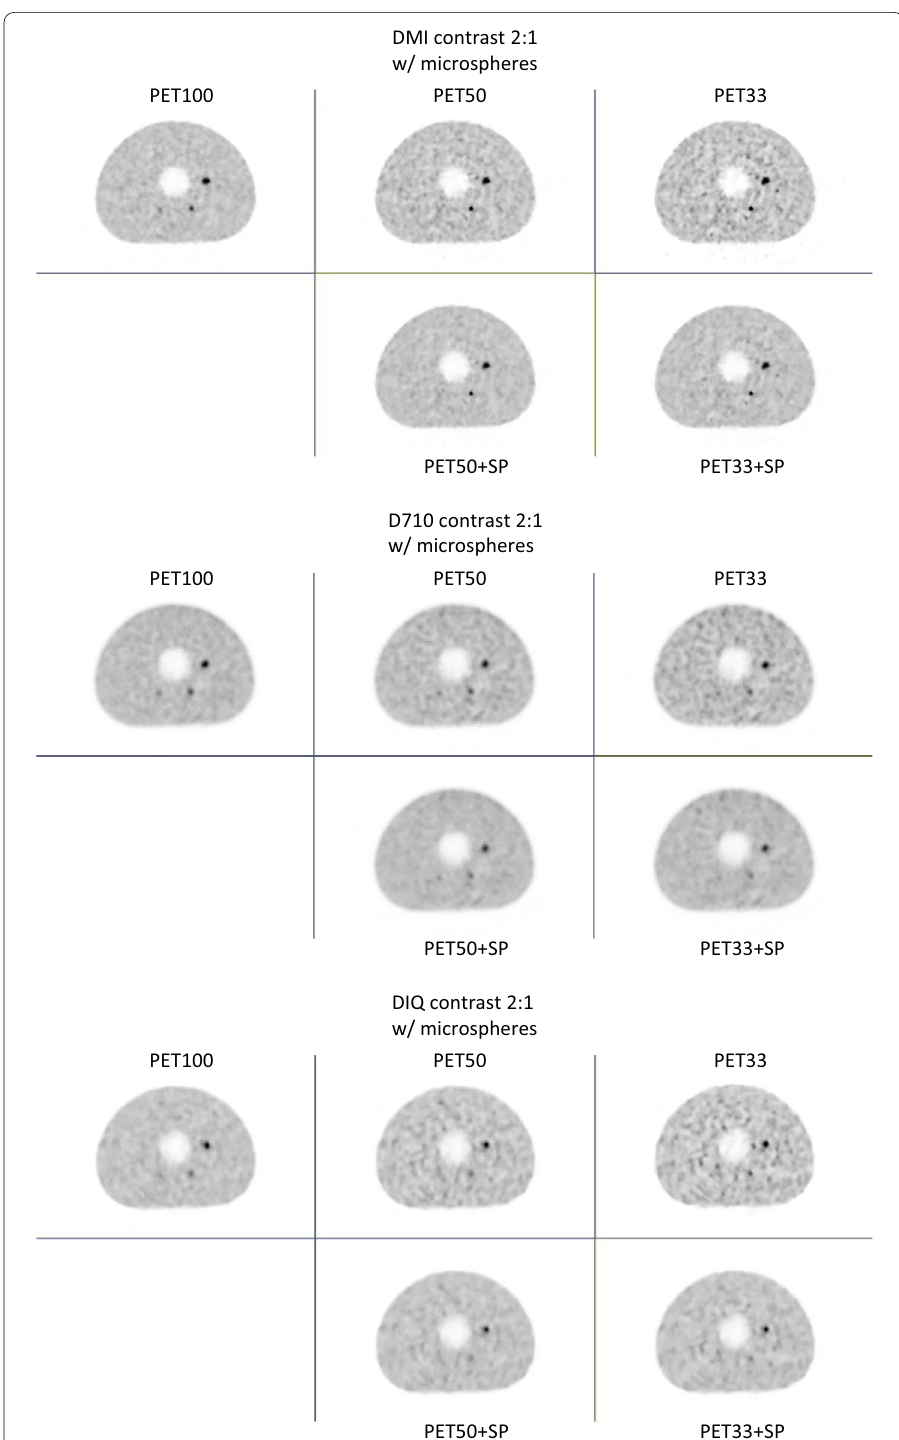
Fig. 3 Images from the IEC phantom acquisition equipped with microspheres, for a contrast of 5:1, for each PET system (Top image: DMI; Middle image: D710 and bottom image: IQ4), acquisition time (1st column: PET100, 2nd colomn: PET50 and 3rd column: PET33) and the application of SubtlePET (2nd row of each